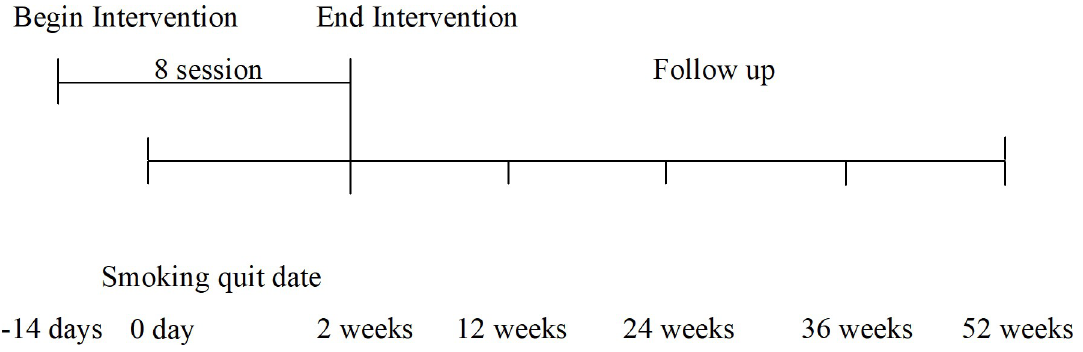
Fig 1. Schematic representation of the intervention and follow-up